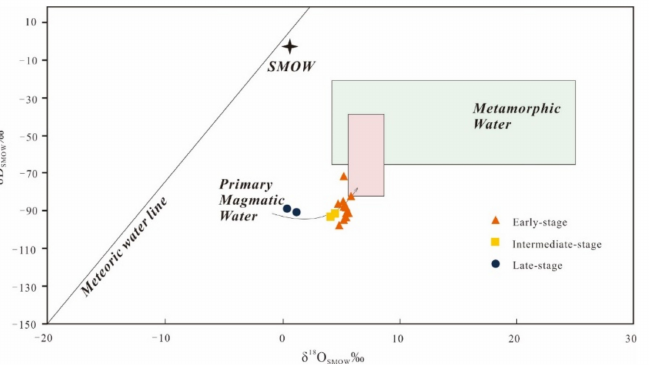
Figure 8. δ 18 O- δ D plots of the ore fluids at the Juyuan tungsten deposit. Domains for metamorphic and magmatic fluids were obtained from [54].